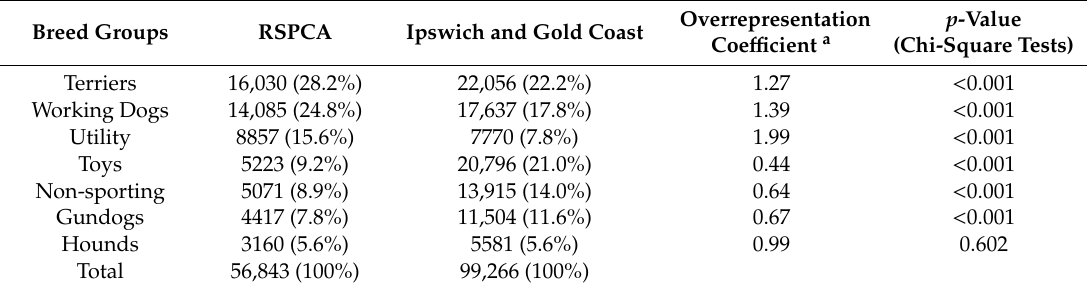
Table 2. Distribution of each breed group in our study, and in Ipswich City Council and Gold Coast City Council registrations, with the overrepresentation coe ffi